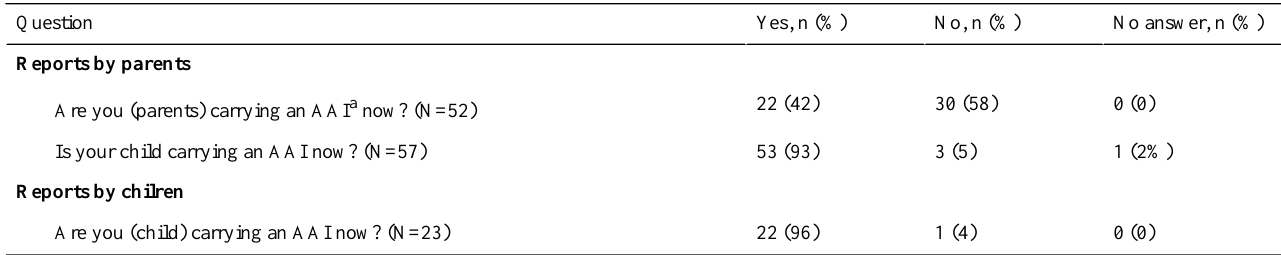
Table 6. Second question about adherence.